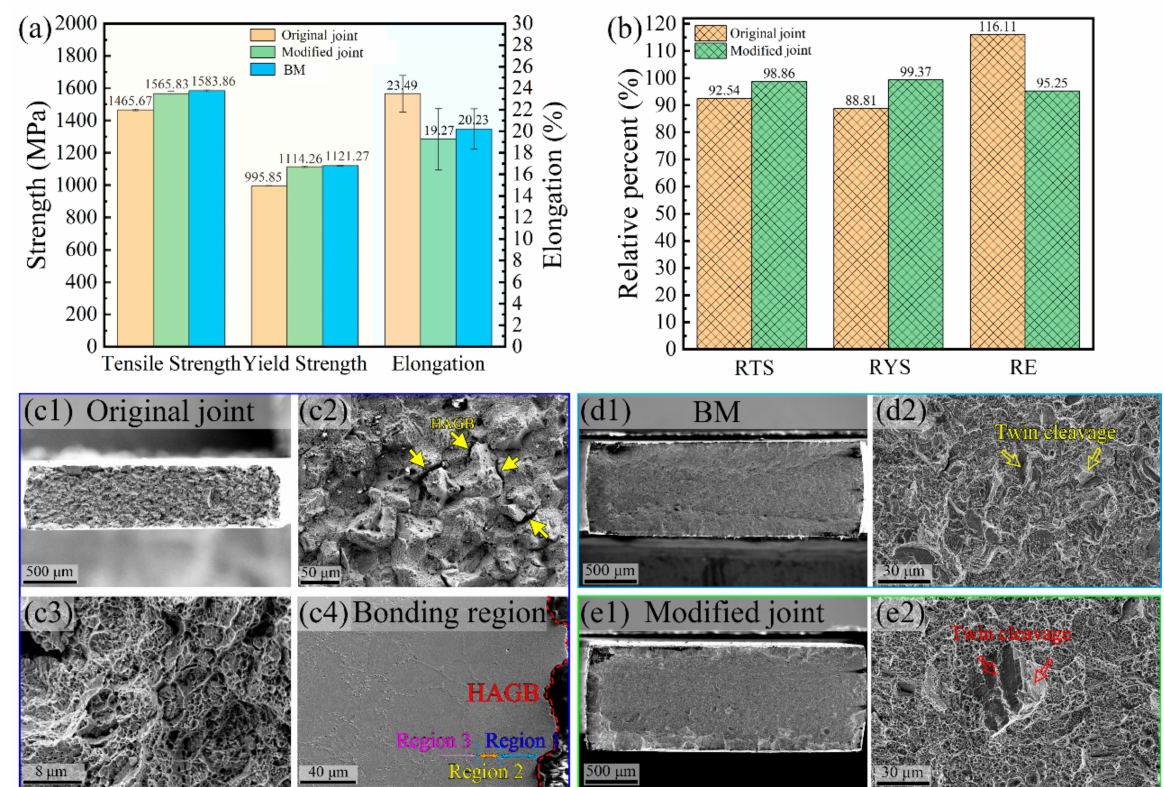
Figure 4. Tensile strength, yield strength, and elongation of the SSDB joints and BM endured with the same bonding process ( a ), and the relative strength and elongation for different joints ( b ). Fracture morphology of SSDB joint with different bonding processes ( c1 – c4 , e1 , e2 ) and BM ( d1 , d2